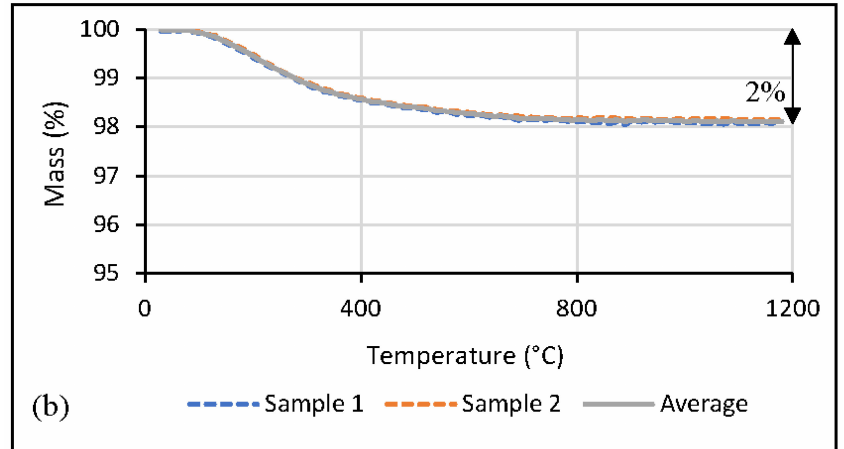
Figure 4. ( a ) Specific heat and ( b ) mass loss of expanded perlite.